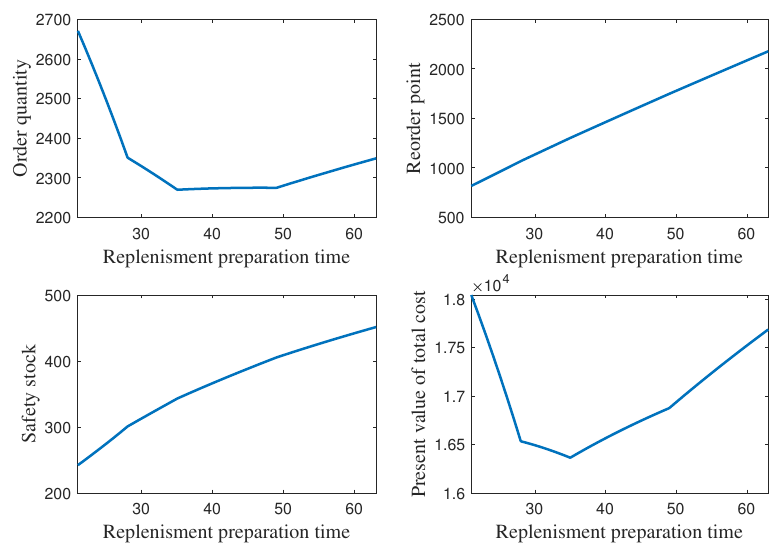
Figure 7. Plots of Q , R , SS , and PVC ( Q , R , L ) under different L